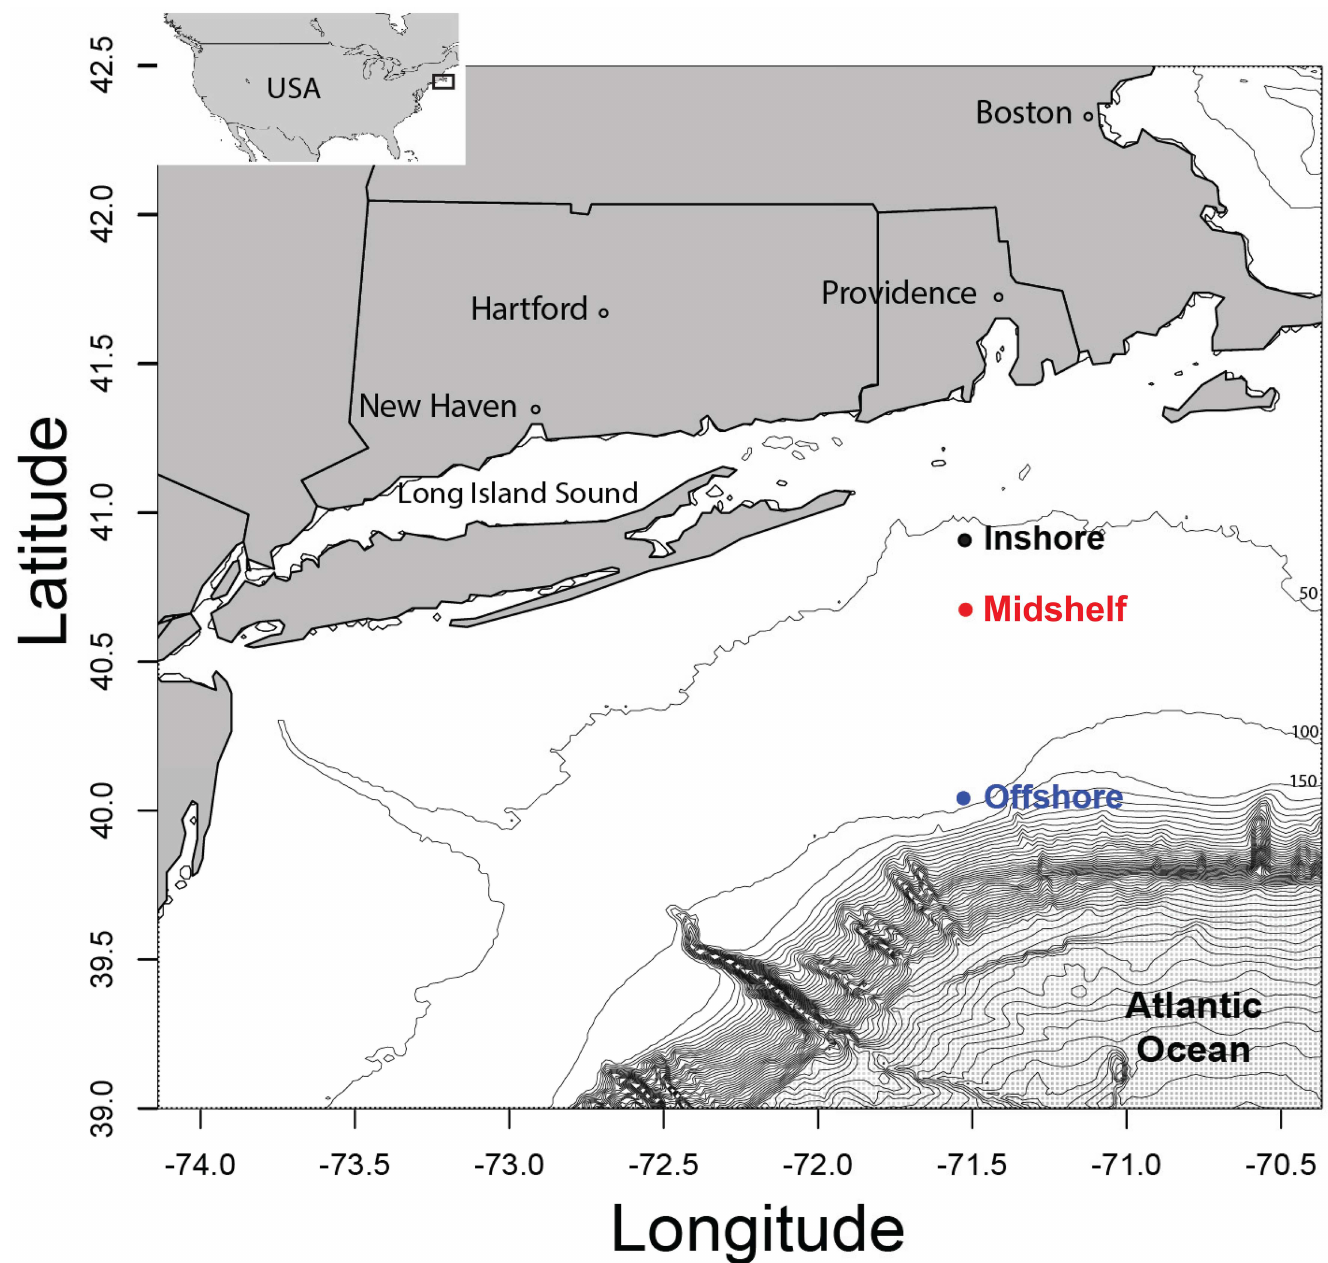
Fig 1. The three sampling locations on the New England shelf beyond Narragansett Bay. For each samplinglocation,we sampledthe second station 1Km away from the first one, and the third 2Km away from the second station (see S1 Fig for more